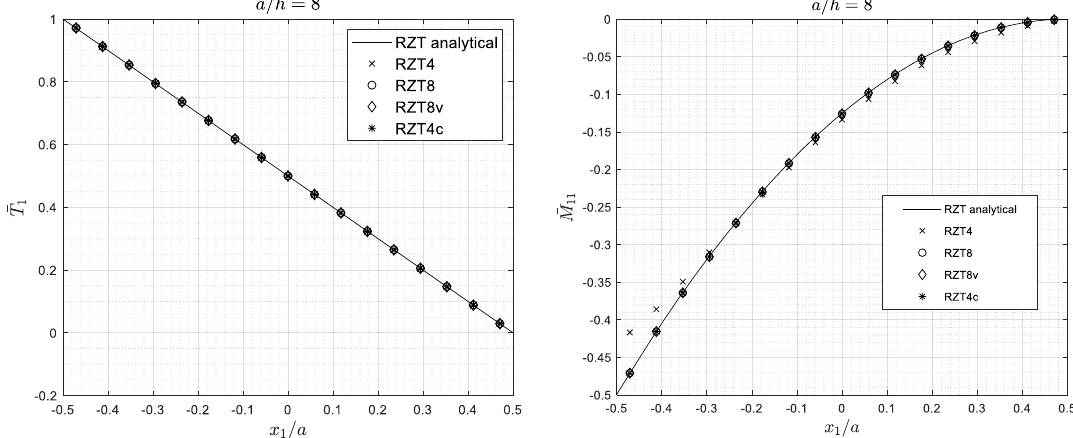
Figure 14. Cantilever thick sandwich (S) square plate under uniform transverse pressure (C1). Transverse shear force and bending moment distribution.